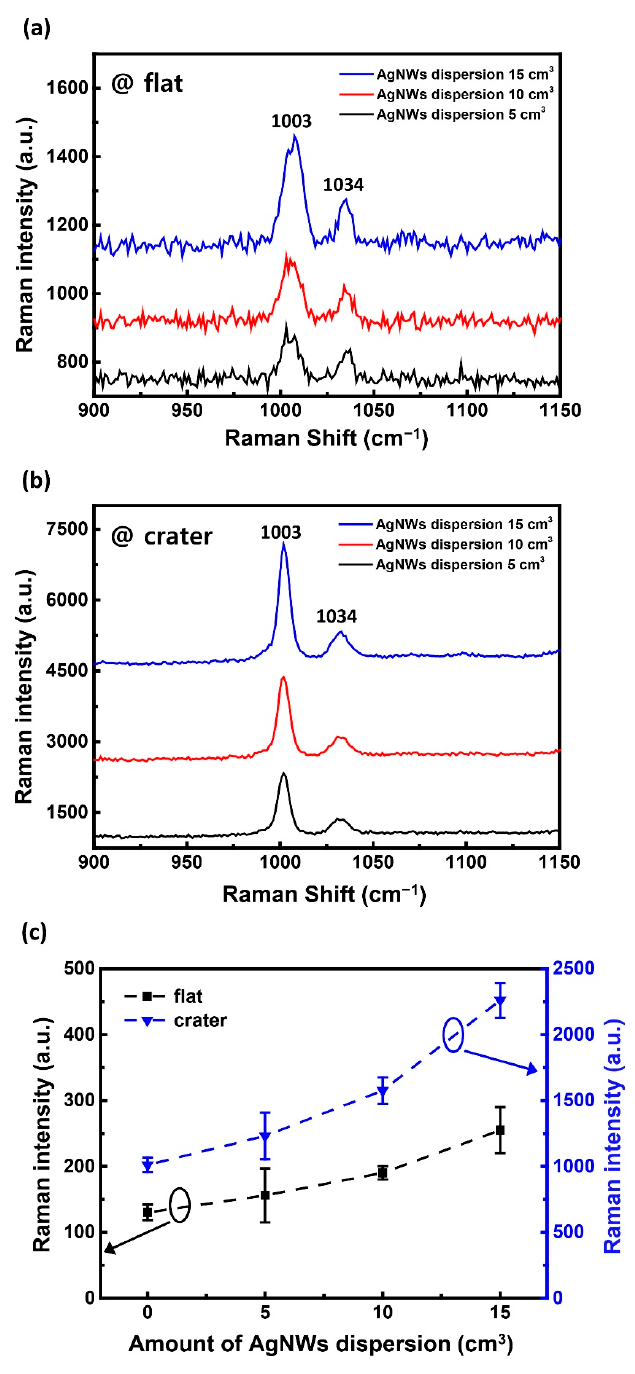
Figure 4. Raman spectra measured in the 0.1 M pyridine solution on ( a ) the flat surface and ( b ) in the crater structure coated with different amount of AgNWs dispersion. ( c ) Relative Raman intensities of the pyridine peak at 1003 cm − 1 according to the amount of AgNWs dispersion.